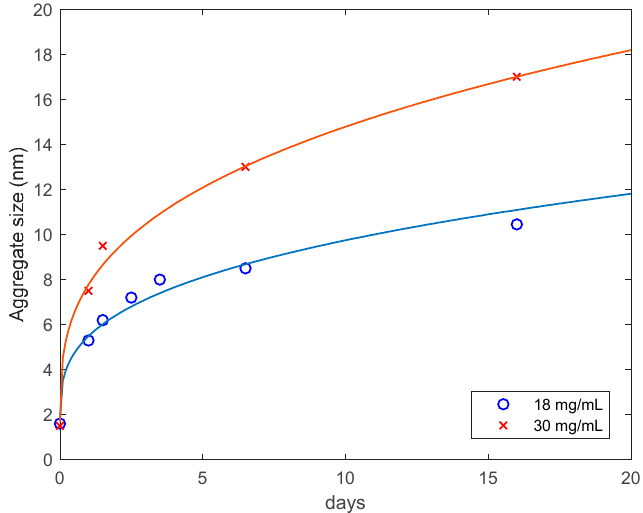
Figure 7. Average hydrodynamic radius of lysozyme aggregates in solutions of 18 mg / mL and 30 mg / mL samples, as a function of time. The solid curves are approximations with Equation (3). Table 1. Fitting parameters in the di ff usion-limited aggregation law, with d f =